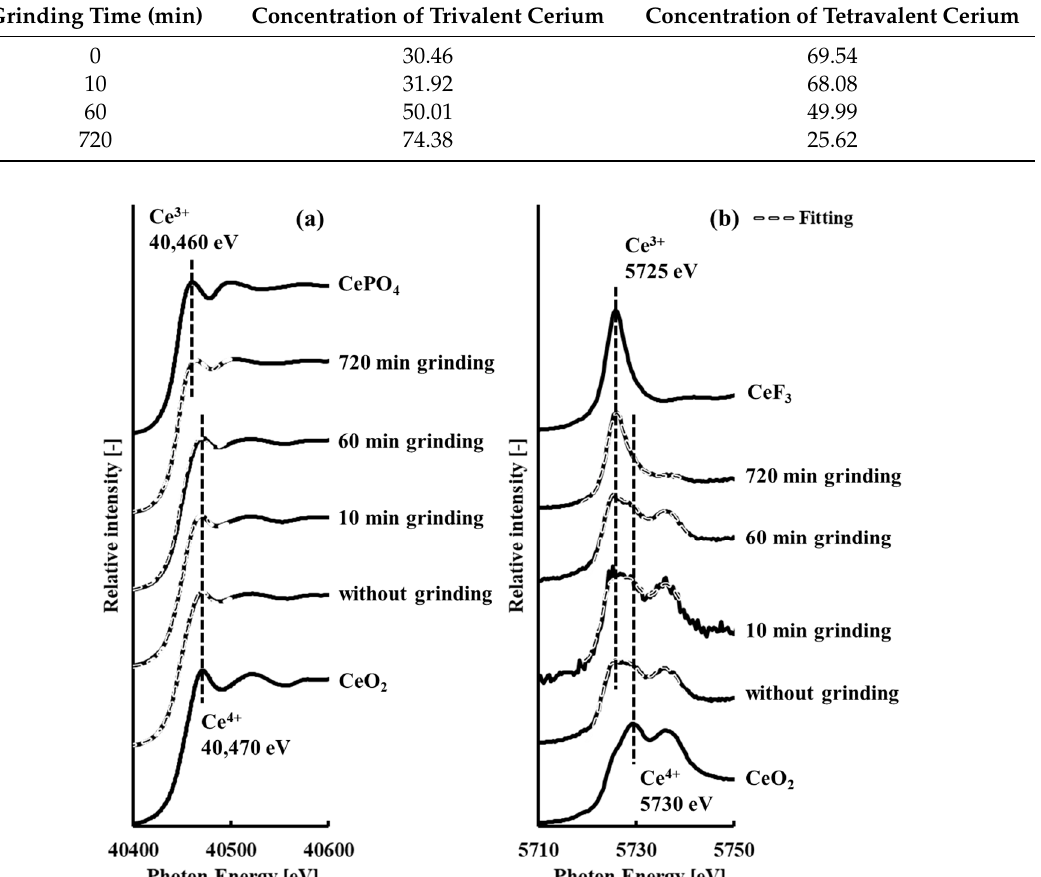
Figure 1. Cerium ( a ) K- and ( b ) L III -edge X-ray absorption fine structure spectra [2] corresponding to X-ray absorption near the edge structure region of samples with and without grinding, showing resolved components of tri- and tetravalent cerium based on cerium fluoride or cerium phosphate and tetravalent cerium oxide reference spectra, respectively.